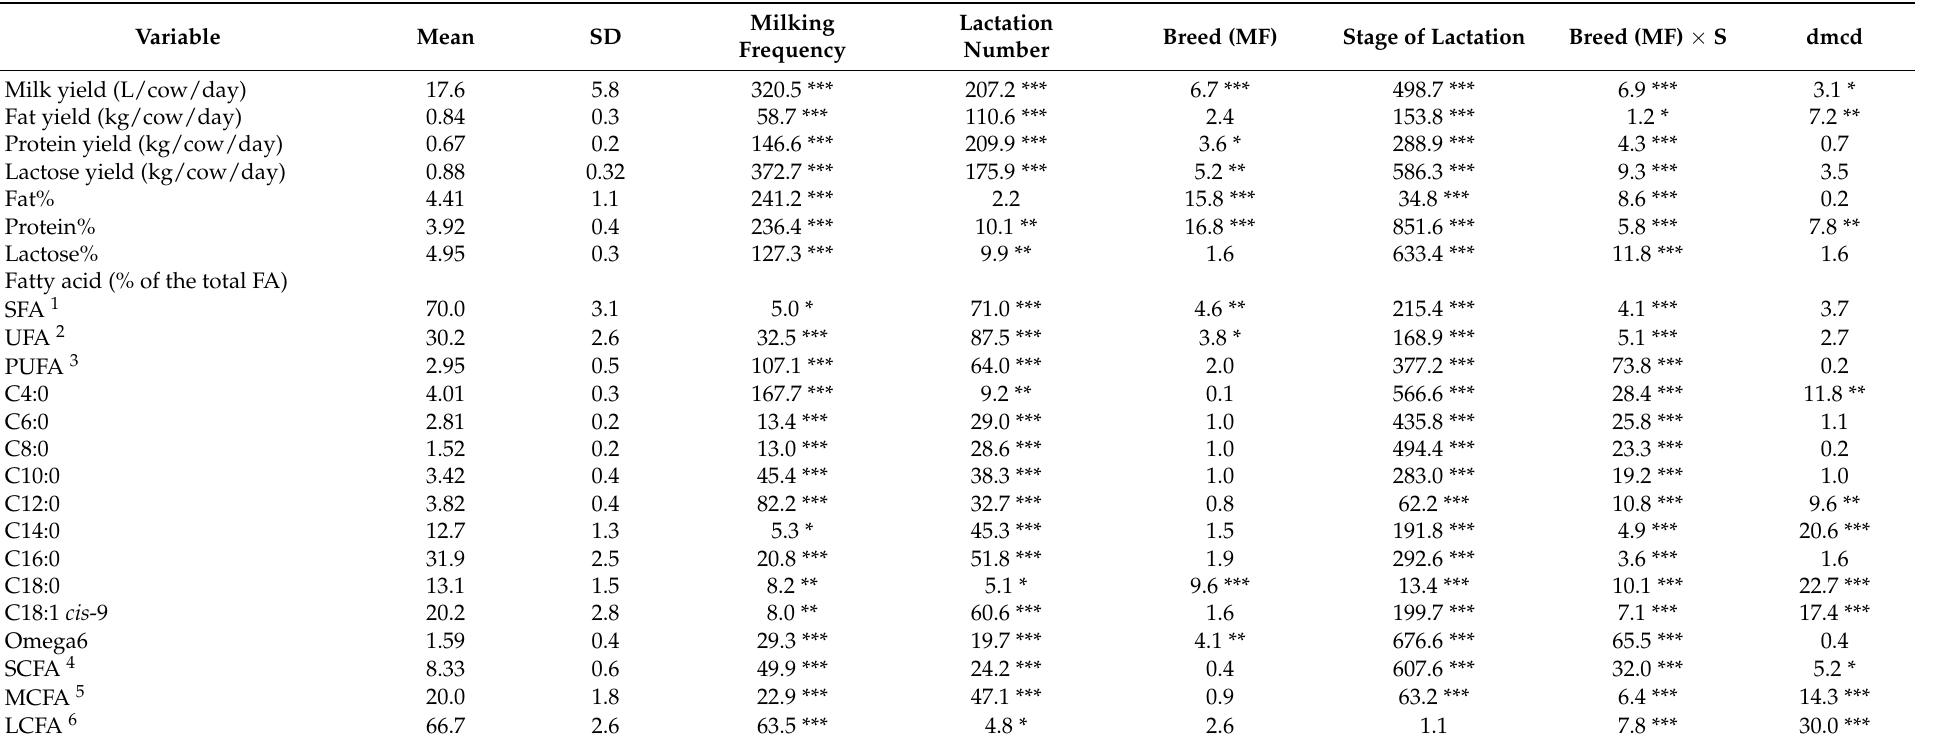
Table 2. Means, standard deviations, and F-value for factors affecting production traits, milk composition, and fatty acid composition of cows milked once-a-day (OAD) and twice-a-day (TAD) during the 2020–2021 production